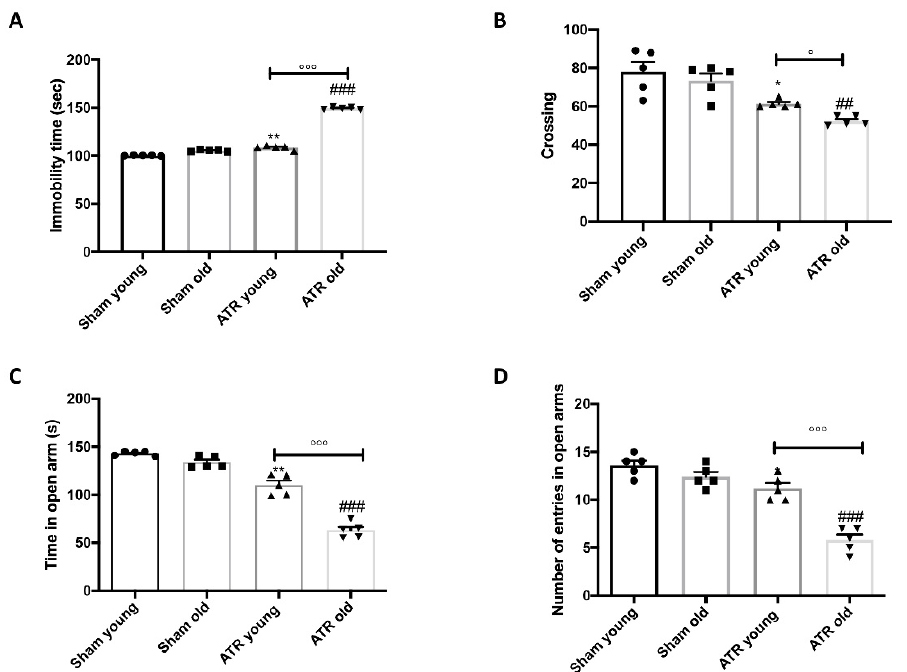
Figure 1. Effect of ATR inhalation on anxiety and depression. Forced Swim Test ( A ); Open Field test ( B ); Time in open arms ( C ) and number of entries in open arms ( D ) was recorded during Elevated Plus Maze test. During the behavioral tests we found that aged mice were more susceptibility compared to young to show anxiety and depression after ATR inhalation. Data is expressed as the mean ± SEM of n = 5 animals for each group. * p < 0.05 vs. Sham young; ** p < 0.01 vs. Sham young; ## p < 0.01 vs. Sham old; ### p < 0.001 vs. Sham old; ° p < 0.05 ATR old vs. ATR young; °°° p < 0.001 ATR old vs. ATR young.